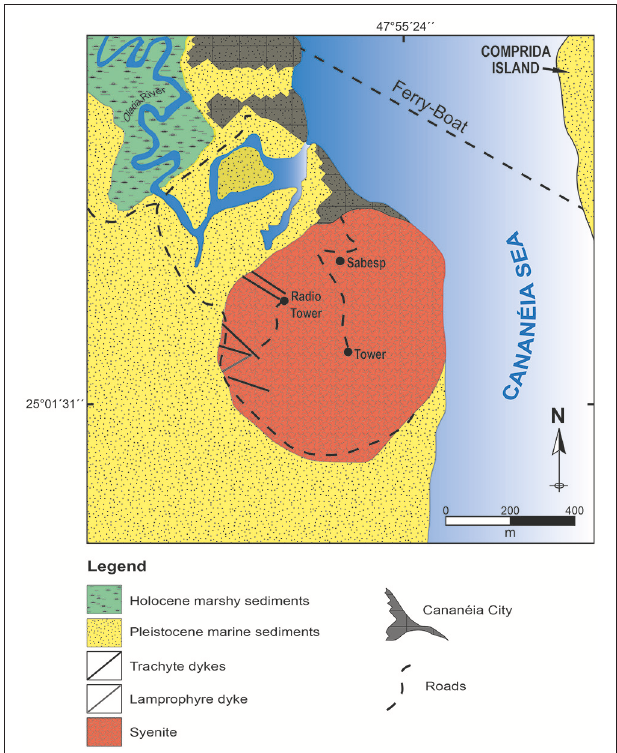
FIGURE 2 | Geologic map of the Cananéia Alkaline Massif area (adapted from Riccomini, 1995 with